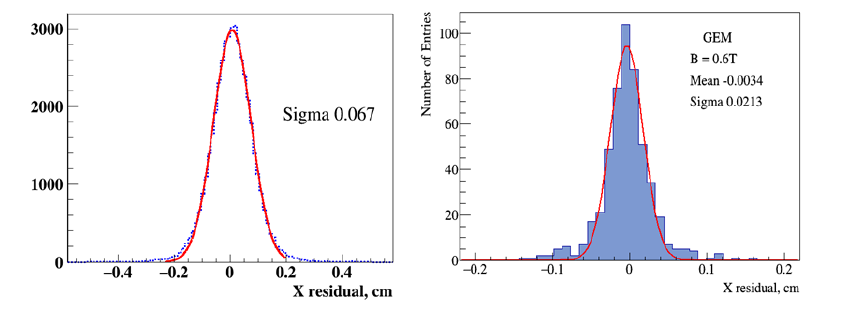
Figure 3. GEM hit residuals for a magnetic field of 0.6 T for di ff erent gas